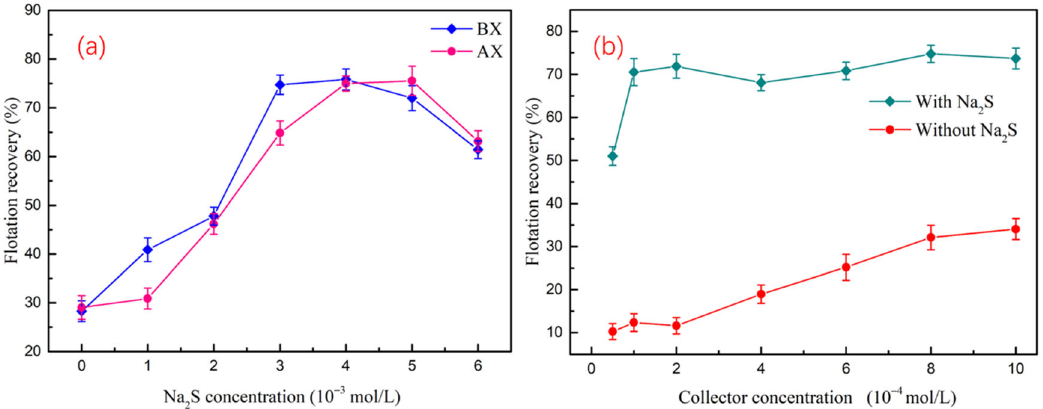
Figure 3. Flotation recovery of malachite as a function of ( a ) Na 2 S dosage ( c (collector) = 1.0 × 10 − 3 mol/L; pH = 9.5) and ( b ) BX dosage in the absence and presence of Na 2 S ( c (Na 2 S) = 3.0 × 10 − 3 mol/L; pH = 9.6).